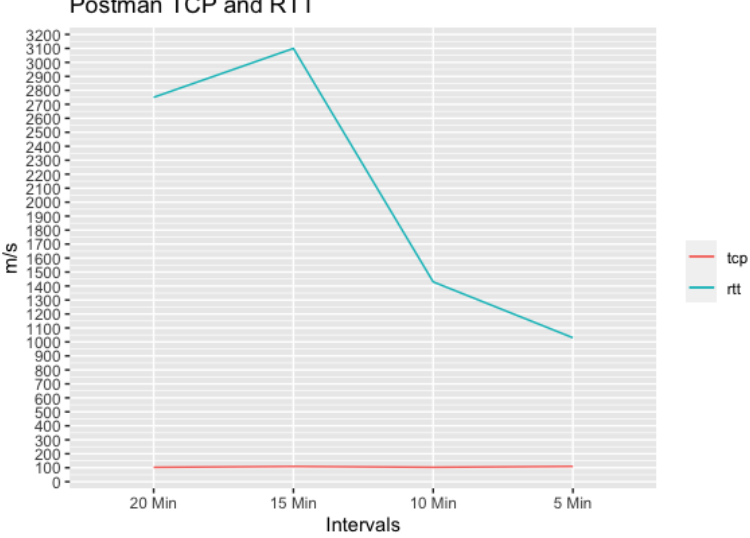
Figure 19. Postman Test TCP and Round-Trip-Time per Request Rate: Red Line, TCP time (ms); Blue Line, Round-Trip-Time time